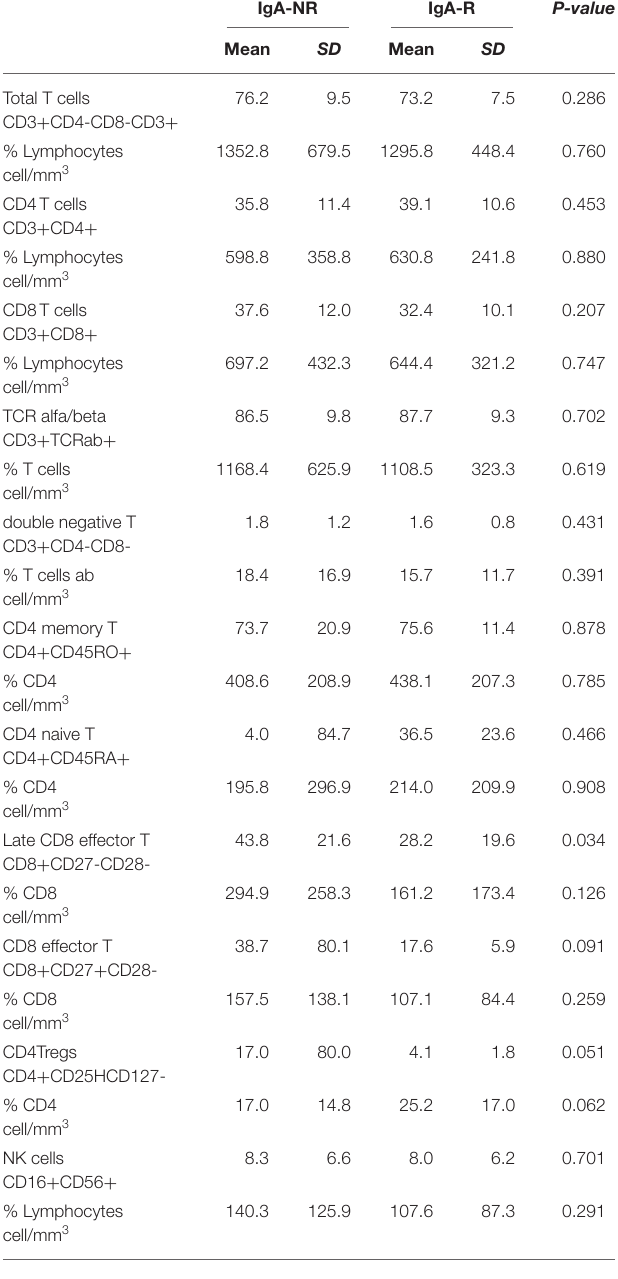
level of specific anti PnPS IgA above the identified cut off (175 ± 13 U/ml) while 4 patients lost the specific IgA (19 ± 18 U/ml) ( Figure 7 ). In the subgroup of long-lasting IgA- R we observed a higher frequency of switched memory B cells in comparison to IgA-R patients who lost IgA response after the first assessment (17.8 ± 5.1% of B cells vs. 9.3 ± 1.7% of B cells, p <